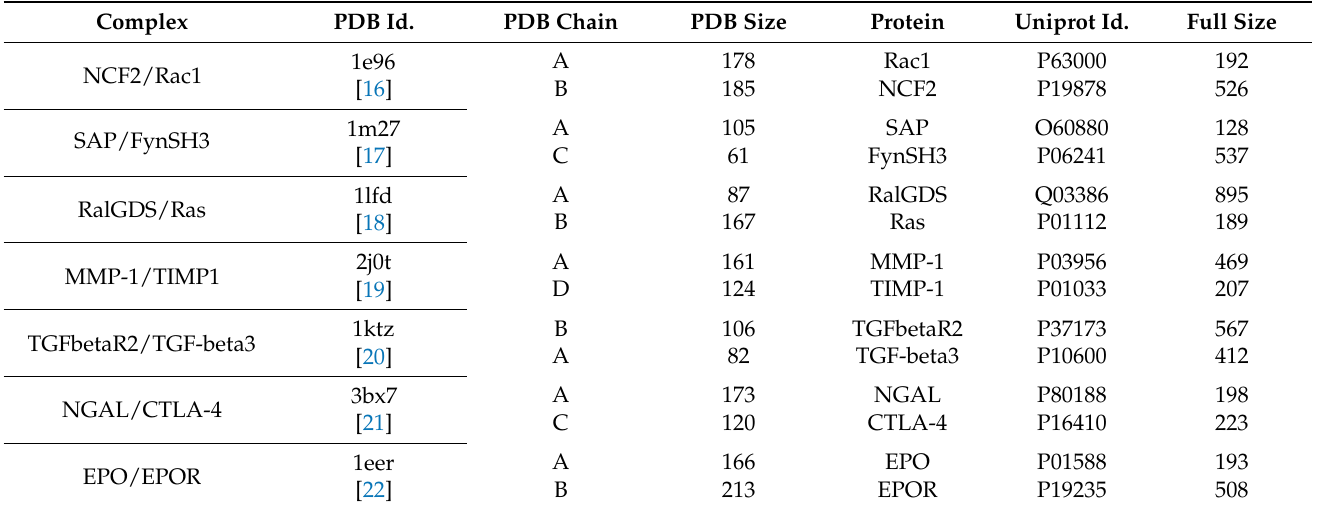
Table 1. Protein-protein complexes of a known structure considered in this study. For each, we detail the PDB identifier and the associated publication, the chains corresponding to the partners, their Uniprot identifiers, and the size of the sequences of the protein as in Uniprot and as in the structure. TGF β : Tumor Growth Factor beta, TGFR: Tumor Growth Factor Receptor, EPO: Erythro- poietin, EPOR: Erythropoietin Receptor, NCF2: Neutrophil Cytosolic Factor, NGAL: Neutrophil Gelatinase-Associated Lipocalin, SAP: SLAM-Associated Protein, MMP1: Matrix Metalloproteinase-1